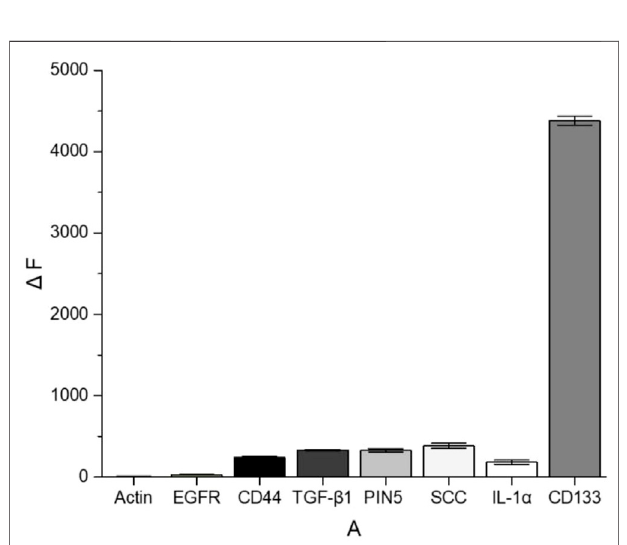
FIGURE 7 | Δ F comparison between CD133 and other common cancer-associated